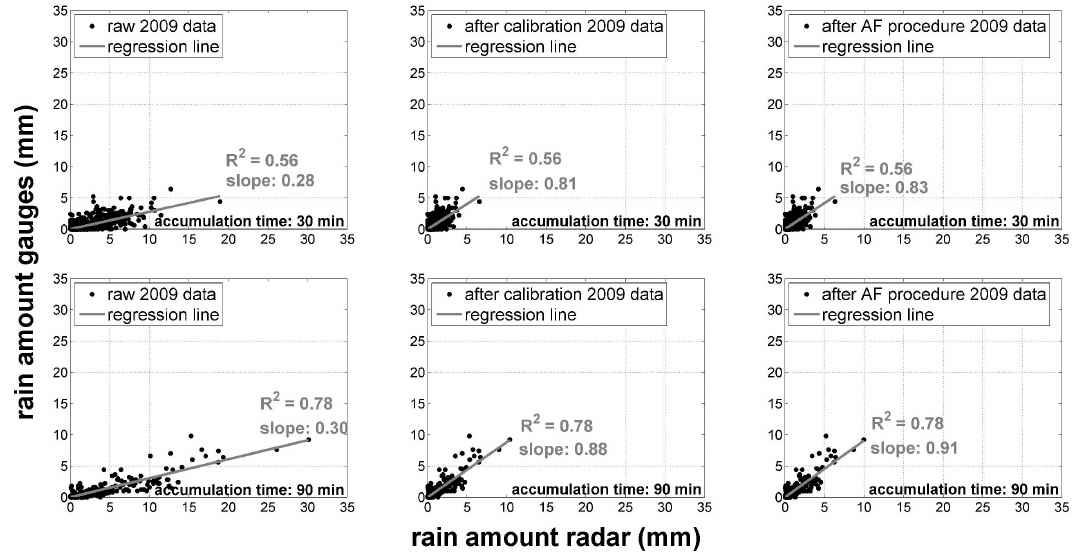
Fig. 14. Scatter plots of rainfall time series’ pairs, obtained during 2009 by Polar 55C and by each rain gauge located from 25 to 40km away from Polar 55C. These refer to a time aggregation of 30 and 90 min (upper panels and lower panels, respectively) for the initial data sets (left panels), after calibration (middle panels) and after the adjustment procedure (right panels).